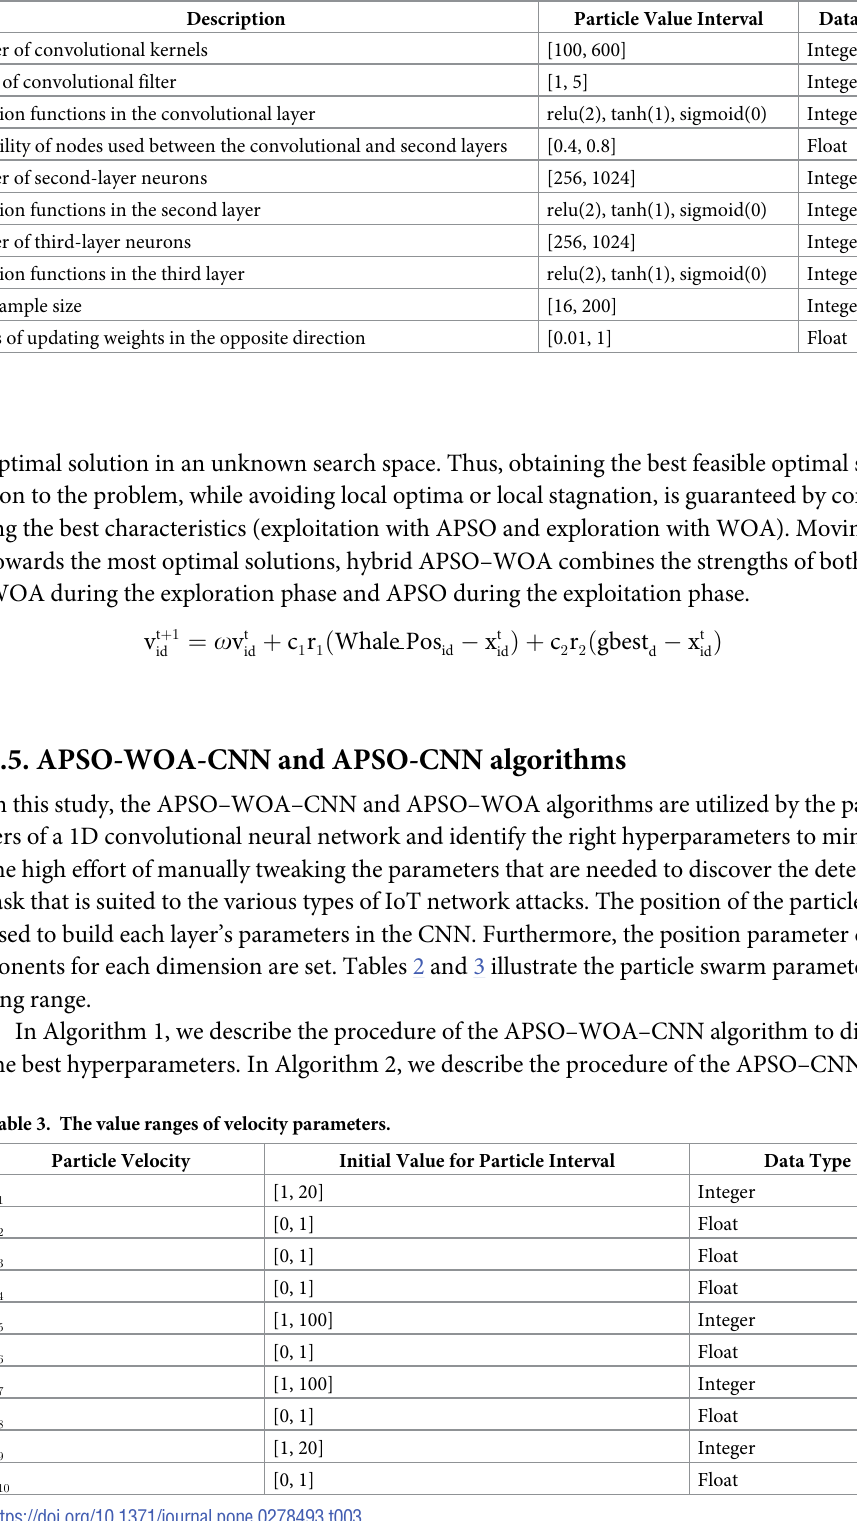
Table 2. The value ranges of position parameters.